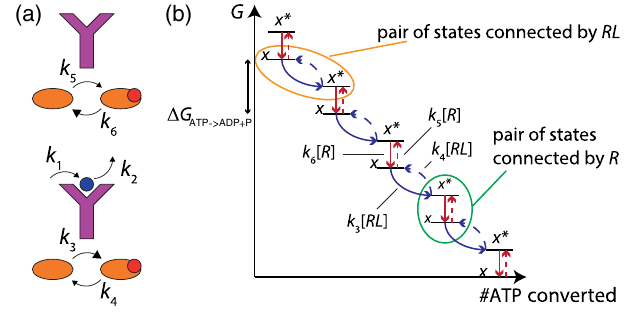
FIG. 1. A canonical signaling network. (a) The signaling network utilizes a receptor that acts as a bifunctional kinase or phosphatase: when bound to a ligand, it catalyzes the activation of the downstream readout; when unbound, it catalyzes the deactivation of the downstream readout. Free-energy dissipation due to the use of fuel, coarse grained from this representation, drives the reactions. (b) Schematic free-energy landscape of a single readout molecule in the biochemical network. We plot the free energy G as a function of the number of ATP molecules that are converted into ADP molecules, for the two states x and x (cid:2) . Thermodynamically favorable transitions are shown with solid arrows, and unfavorable transitions with dashed arrows. The presence of catalysts R and RL makes these transitions faster, and thereby push the system towards x or x (cid:2) , but the overall thermodynamic drive is fixed for both